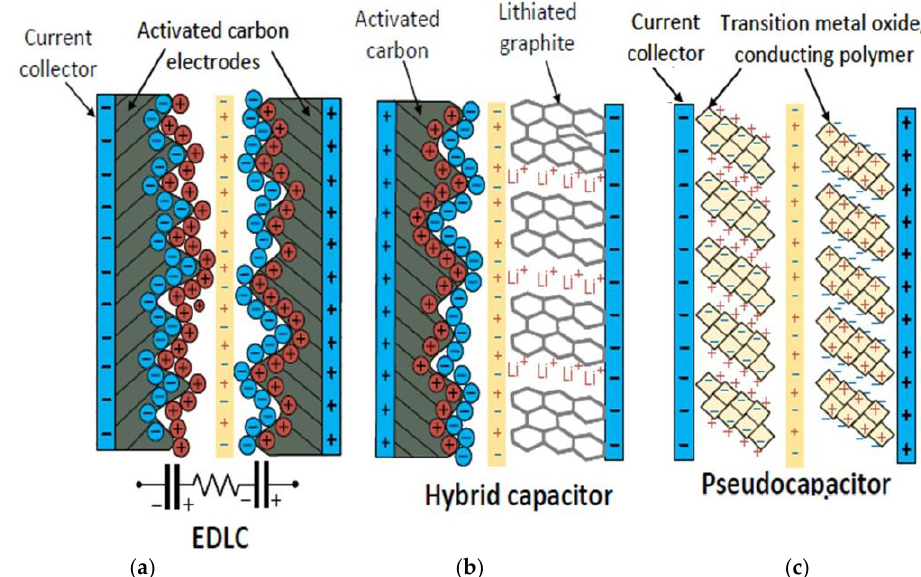
Figure 2. Electro-chemistry of three commercial SC families: ( a ) Electric double layer capacitor, ( b ) hybrid capacitor, ( c ) pseudocapacitor [11,12]. Table 2. Comparison of electric double-layer capacitors and other supercapacitor types